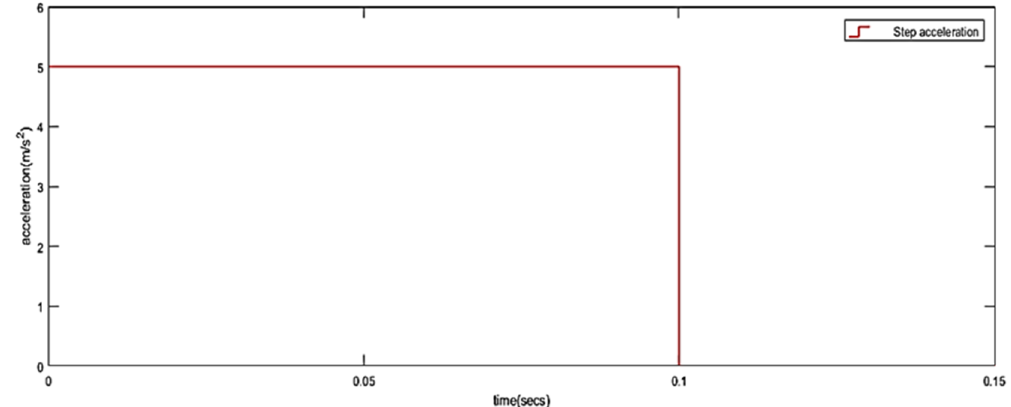
Figure 9. Step acceleration signal.